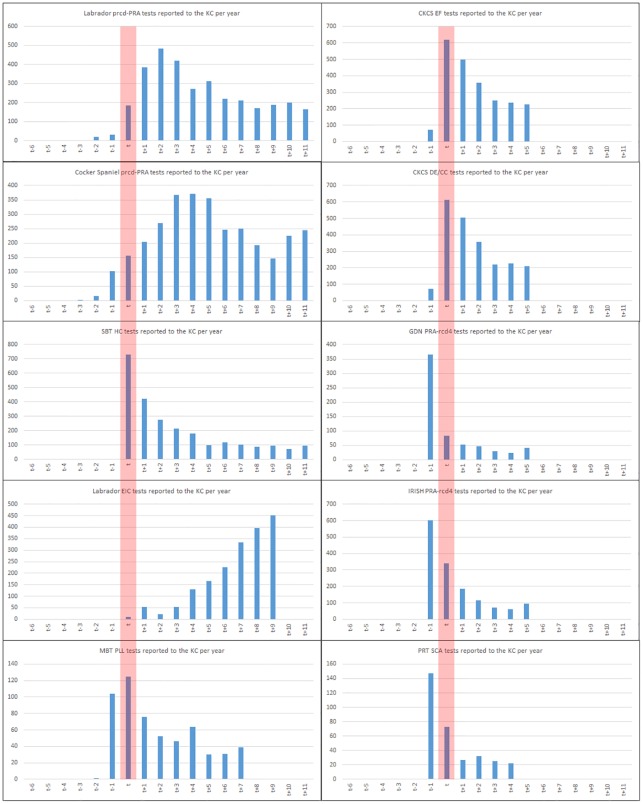
Number of DNA test results per year.Bar charts showing the number of test results reported to the Kennel Club per year for all disorder/breed combinations, where ‘t’ (as indicated by the red bar) is the year that the mutation was published (as in Table 1) thereby standardising the ‘testing profile’ by commercial availability rather than chronological year.